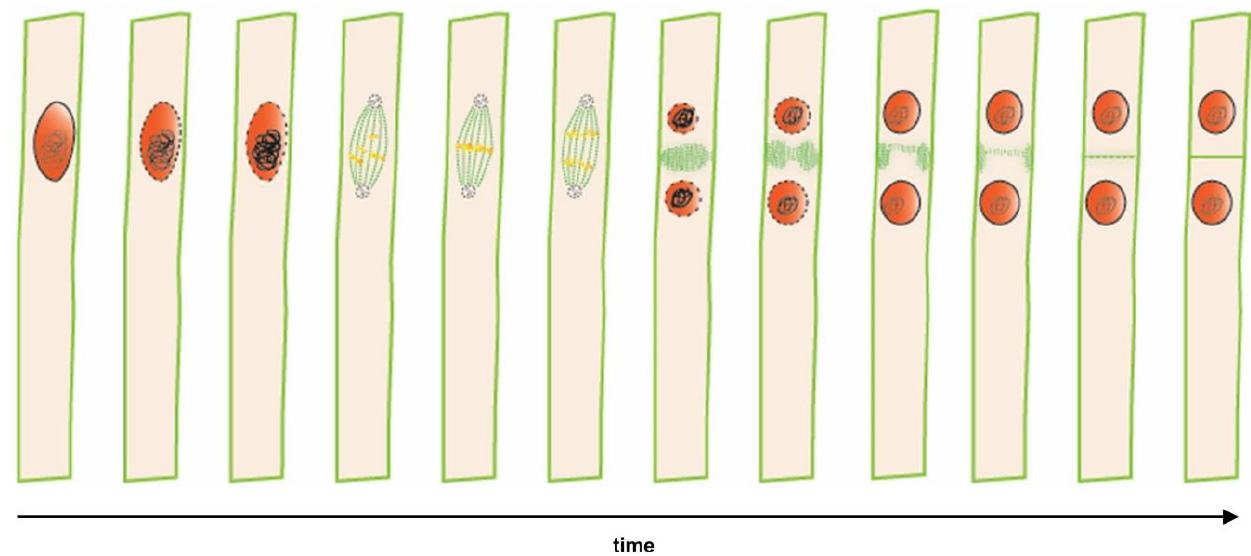
Figure 1. Time lapse from lateral root founder cell specification to asymmetric cell division in a single xylem pole pericycle cell. Sequential cellular events preceding the first asymmetric division that indicates nuclei (in red ) and microtubules (in green ). Polar migration of the nucleus in a lateral root founder cell is followed by an asymmetric anticlinal cell division, resulting in a short and a long daughter cell.